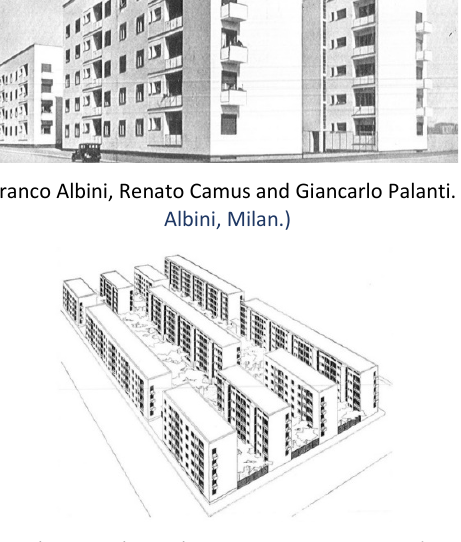
Figure 11 Quartiere Fabio Filzi. Photographer unknown, Renato Camus and Giancarlo Palanti. 1939. (Biblioteca comunale Paolo Borsellino,